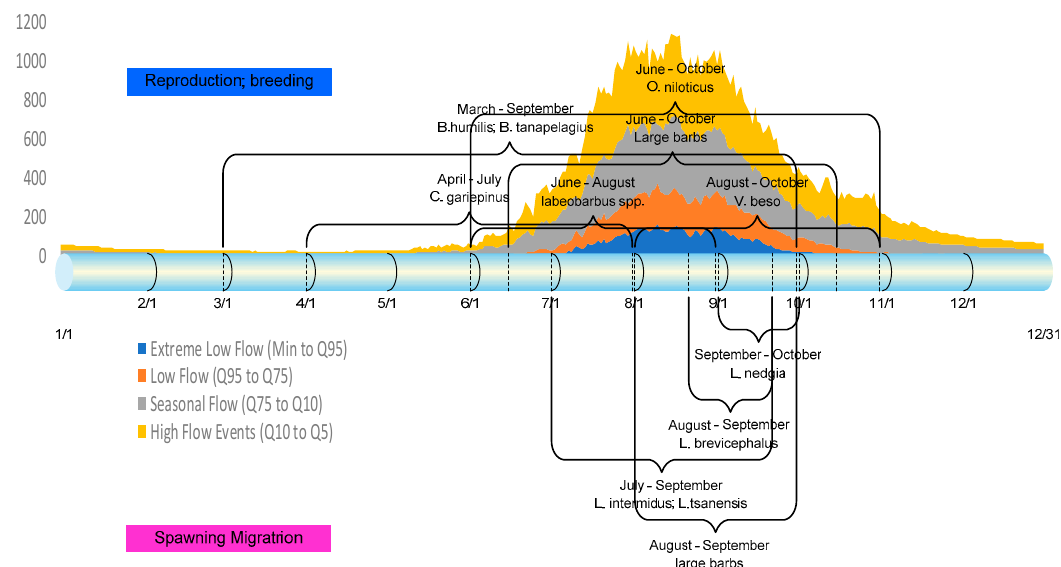
Figure 13. Flow Components vis-a-vis Spawning Migration Period (Below the line) and Reproduction Period (Above the line) of Fish Species in Lake Tana-Gumara River. Spawning migration and reproduction begin in June and July for most of the fish species. Migration kicks off as freshest water or flow pulses reach the lake, i.e., between high flow pulse begin from 4.8 m 3 s − 1 in June and small flood of 294 m 3 s − 1 in July.